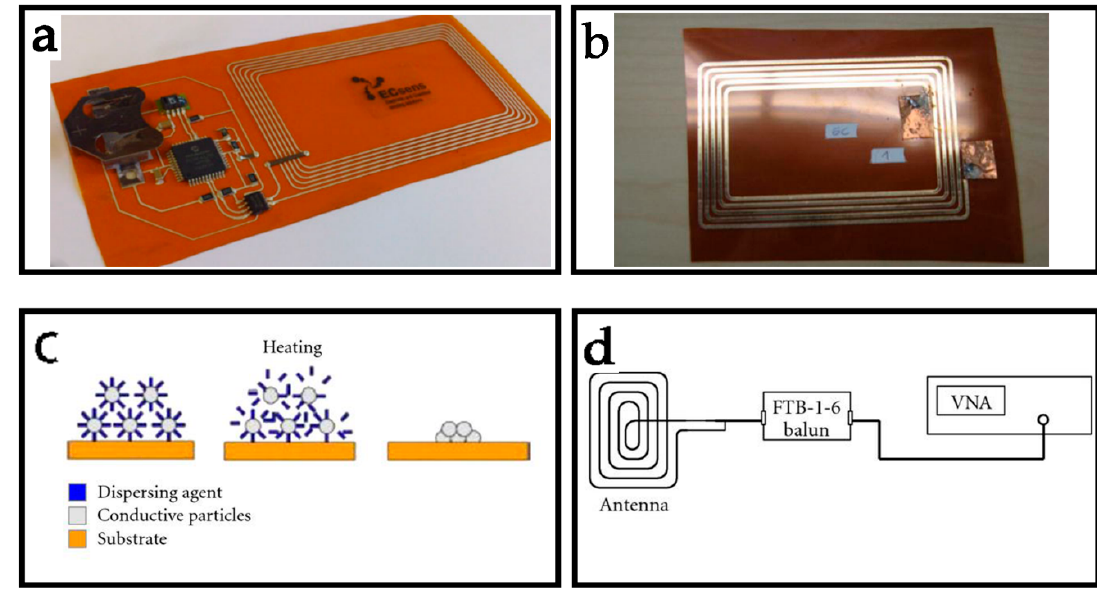
Figure 2. Printing technologies for NFC antenna design. ( a ) Screen printing for NFC antennas.